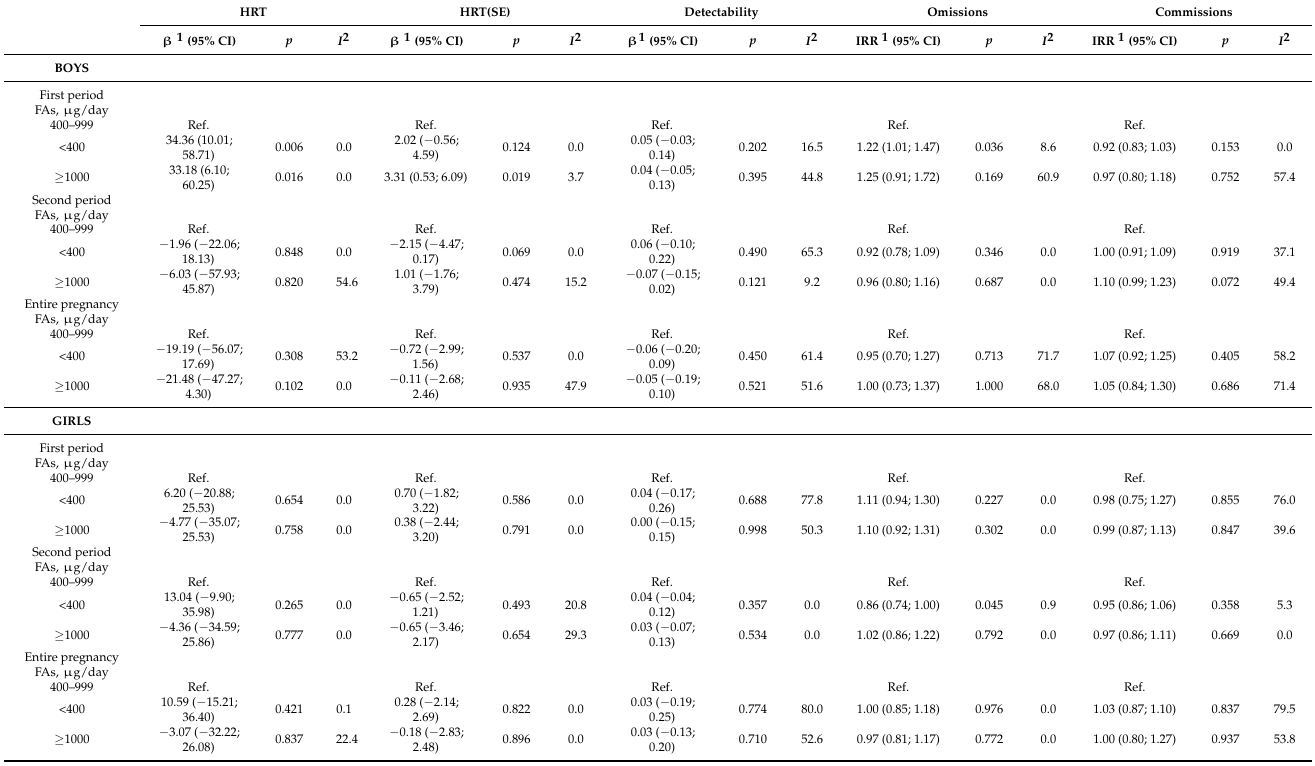
Table 3. Fully-adjusted combined association between FAs use during pregnancy and attentional function outcomes in children aged 4–5 years of the INMA cohort study according to sex; Spain, 2003–2008 ( n boys = 664; n girls = 665). HRT HRT(SE) Detectability Omissions Commissions